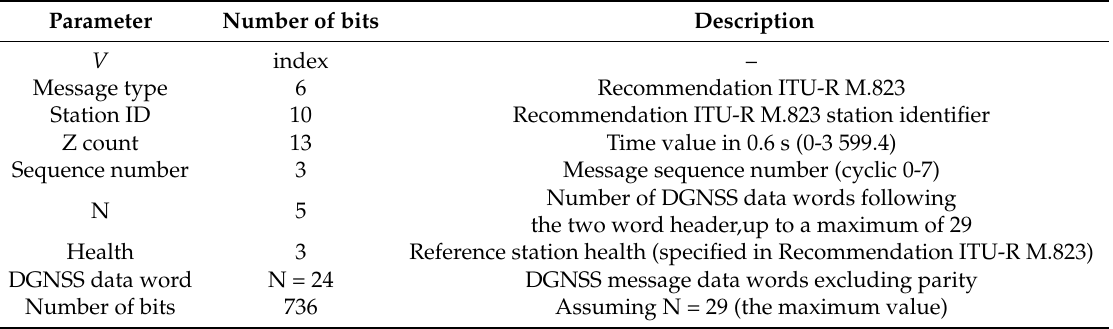
Table 1. Differential correction data parameter